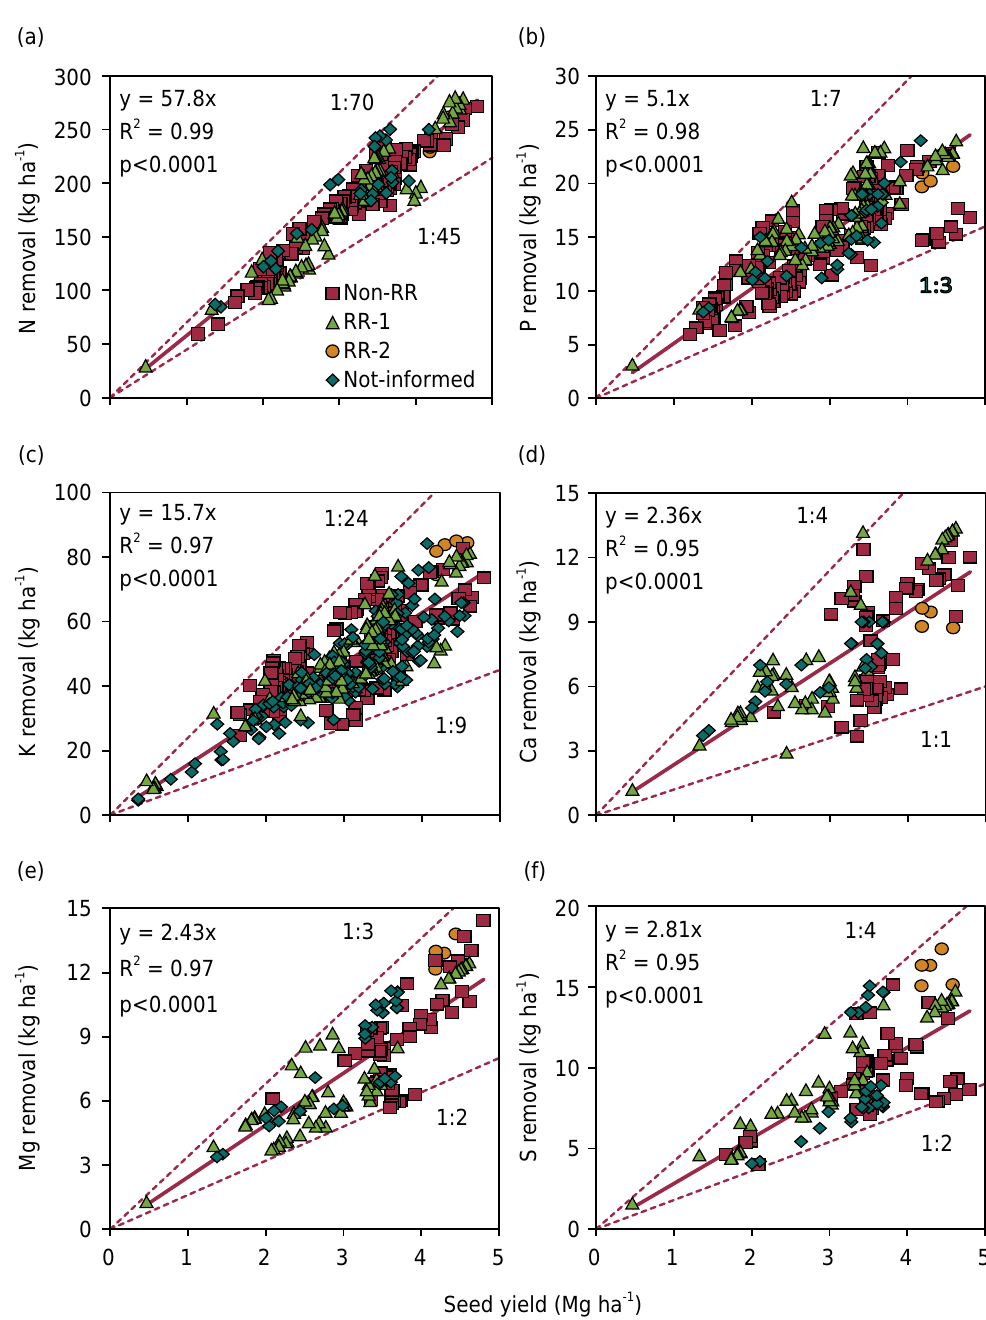
Figure 5. Relationship between soybean yield and the total removal of N (a), P (b), K (c), Ca (d), Mg (e), and S (f) in soybean seeds. Solid black line represents a positive slope (p<0.05). Graphs were generated using all available data from field experiments containing nutrient content and soybean yield from 1974 to 2019. Dotted lines indicate boundaries for maximum and minimum ratio for each